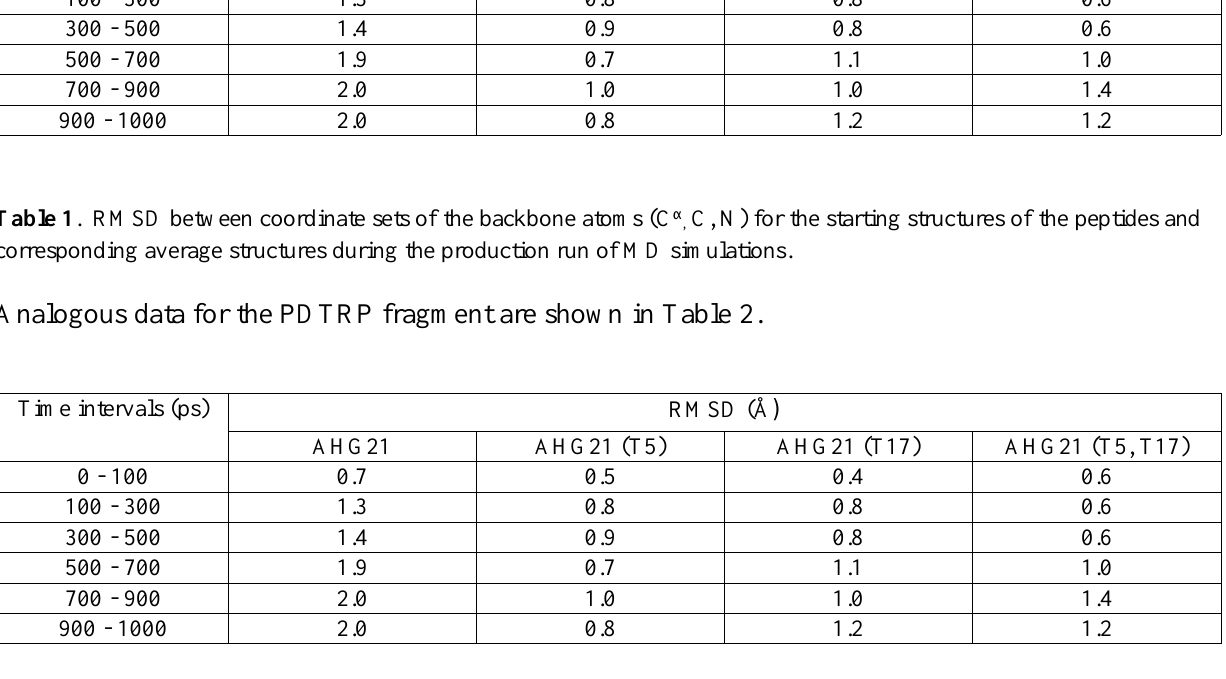
C, N) of the PDTRP fragment for the starting peptide ,